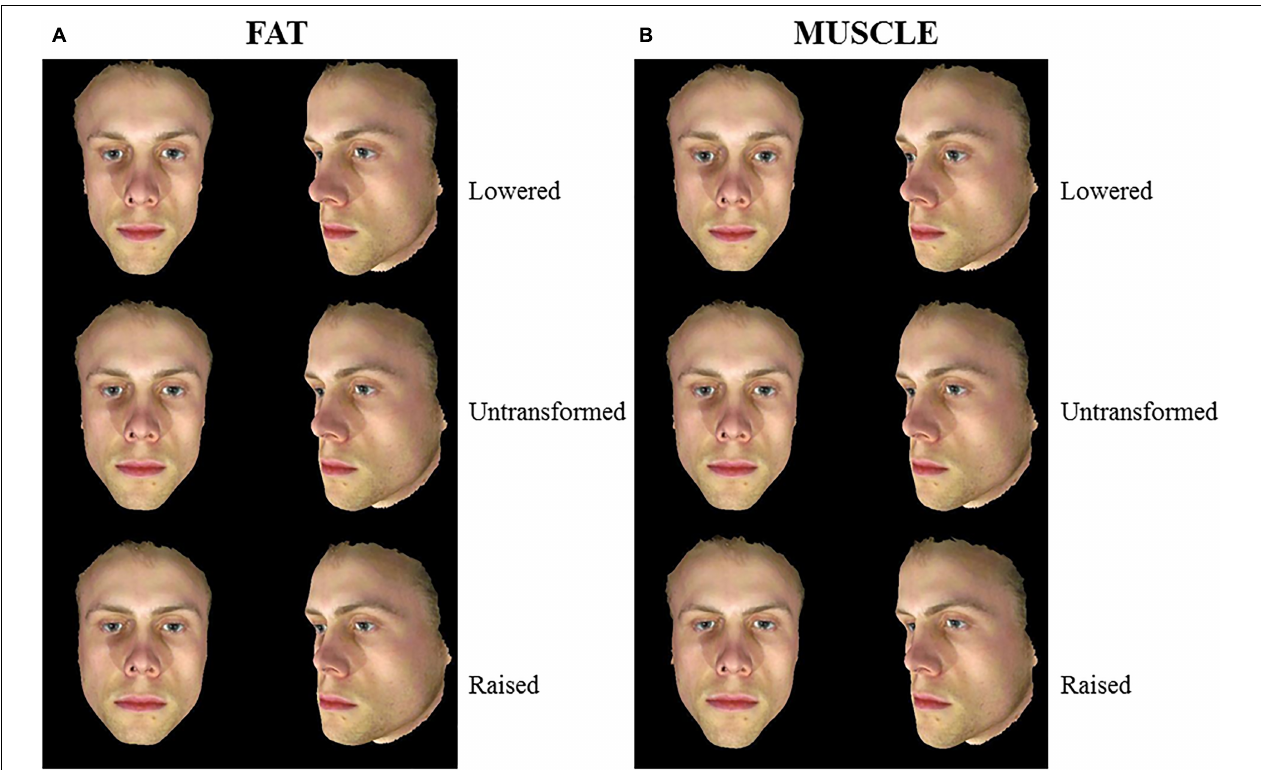
FIGURE 1 | 3D Male face shape associated with fat mass (A) and muscle mass (B) . Individual faces (middle) were transformed to reflect face shapes associated with less fat/muscle mass (–4 BMI units, top) or more fat/muscle mass (+4 BMI units, bottom) based on the difference in the face shape between low and high fat/muscle prototypes for the 3D face set. Front and half-profile views of the same face are displayed. The participant gave written informed consent for the publication of his image and use in the